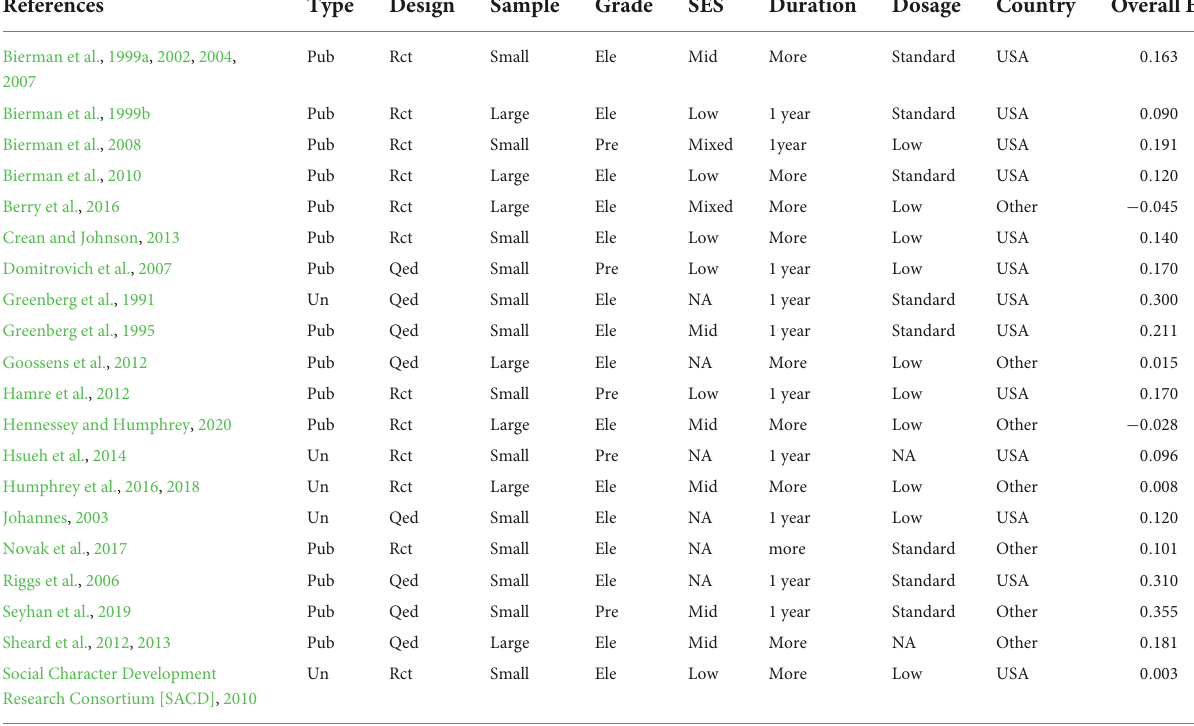
TABLE 1 A brief description of included studies about